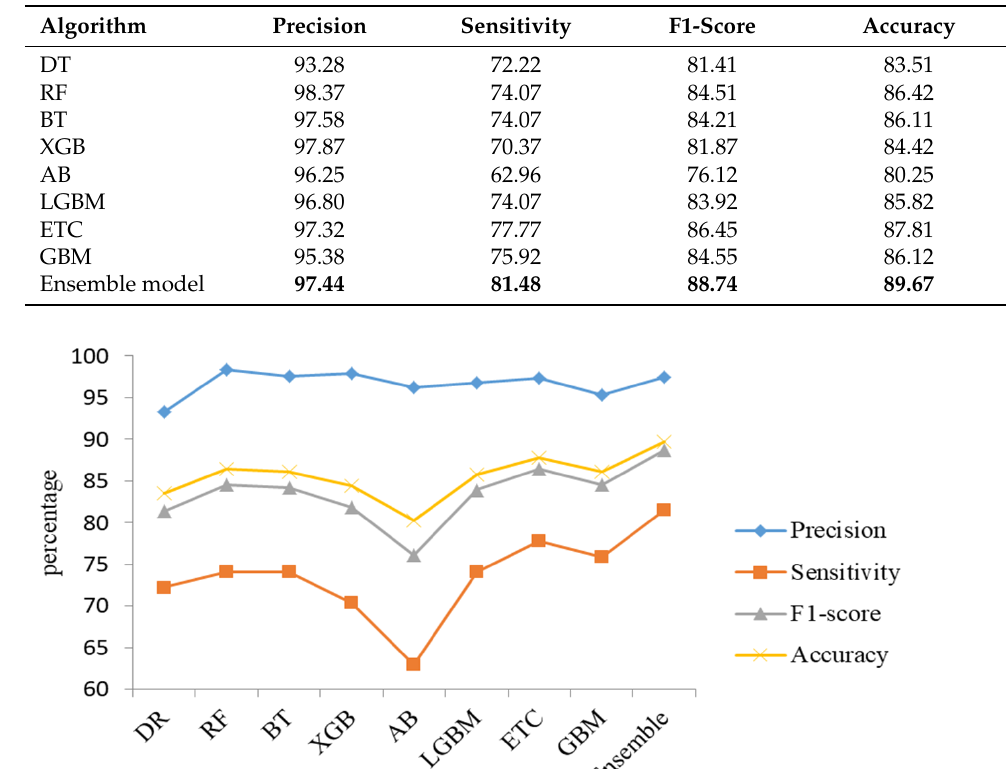
Table 8. Test results of the classification algorithms with respect to hybrid features.